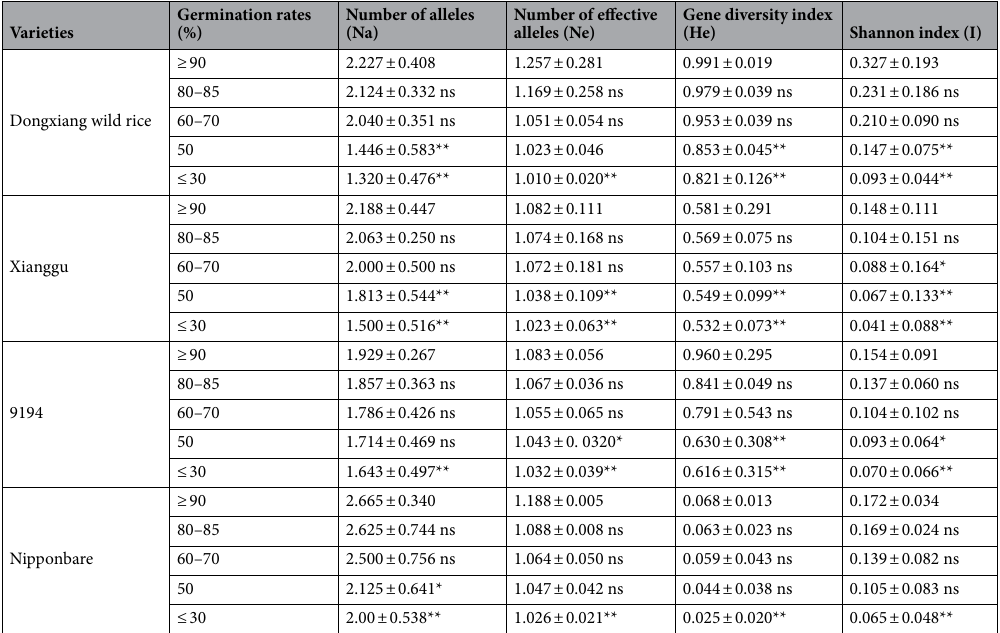
Table 6. Genetic diversity of different varieties with different germination rates. *represents a significant difference at the 5% level, **represents a significant difference at the 1% level, and ns indicates that there is no significant difference. All of the results were compared with the original germination